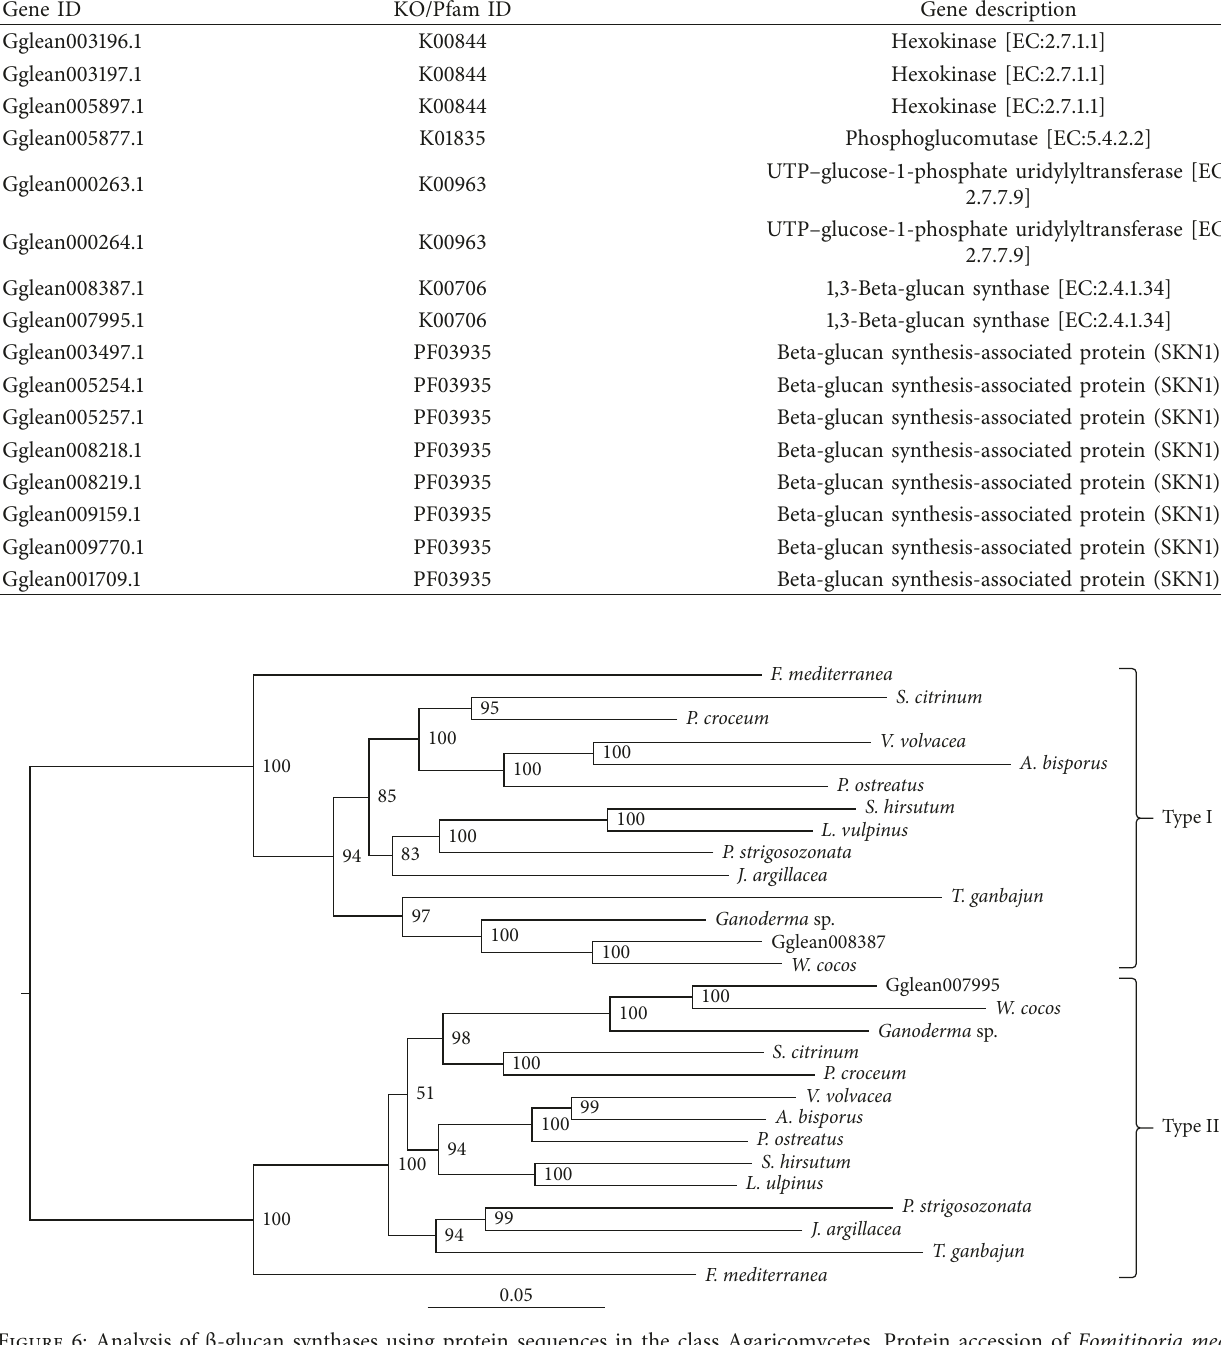
PI 10, Minscore 50, MaxPeriod 2000). We applied (cid:31) (cid:31) (cid:31) rRNA pool alignment and RNAmmer v1.2 (de novo pre- diction) to identify rRNA sequences, tRNAscan-SE v1.3.1